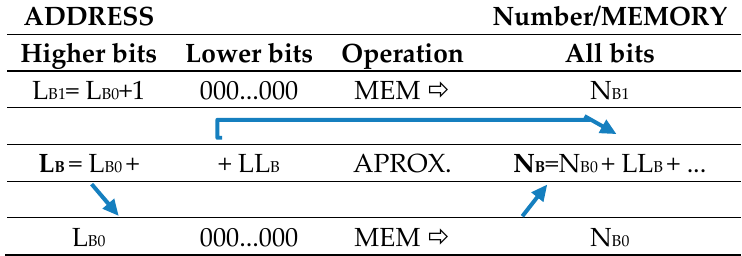
Figure 3. Principle of approximating N B using a simple bit manipulation.